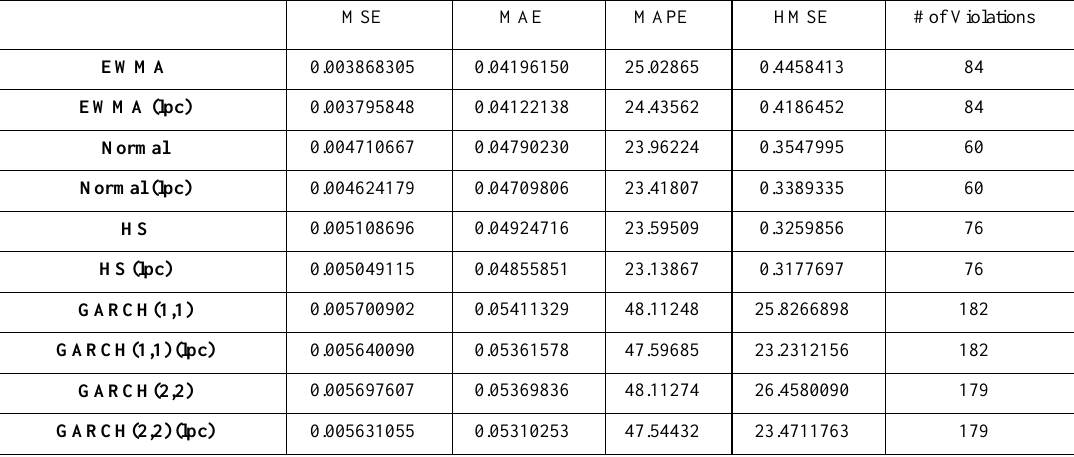
Table 7. Evaluation measures results for PVaR with and without lpc ENRJ –